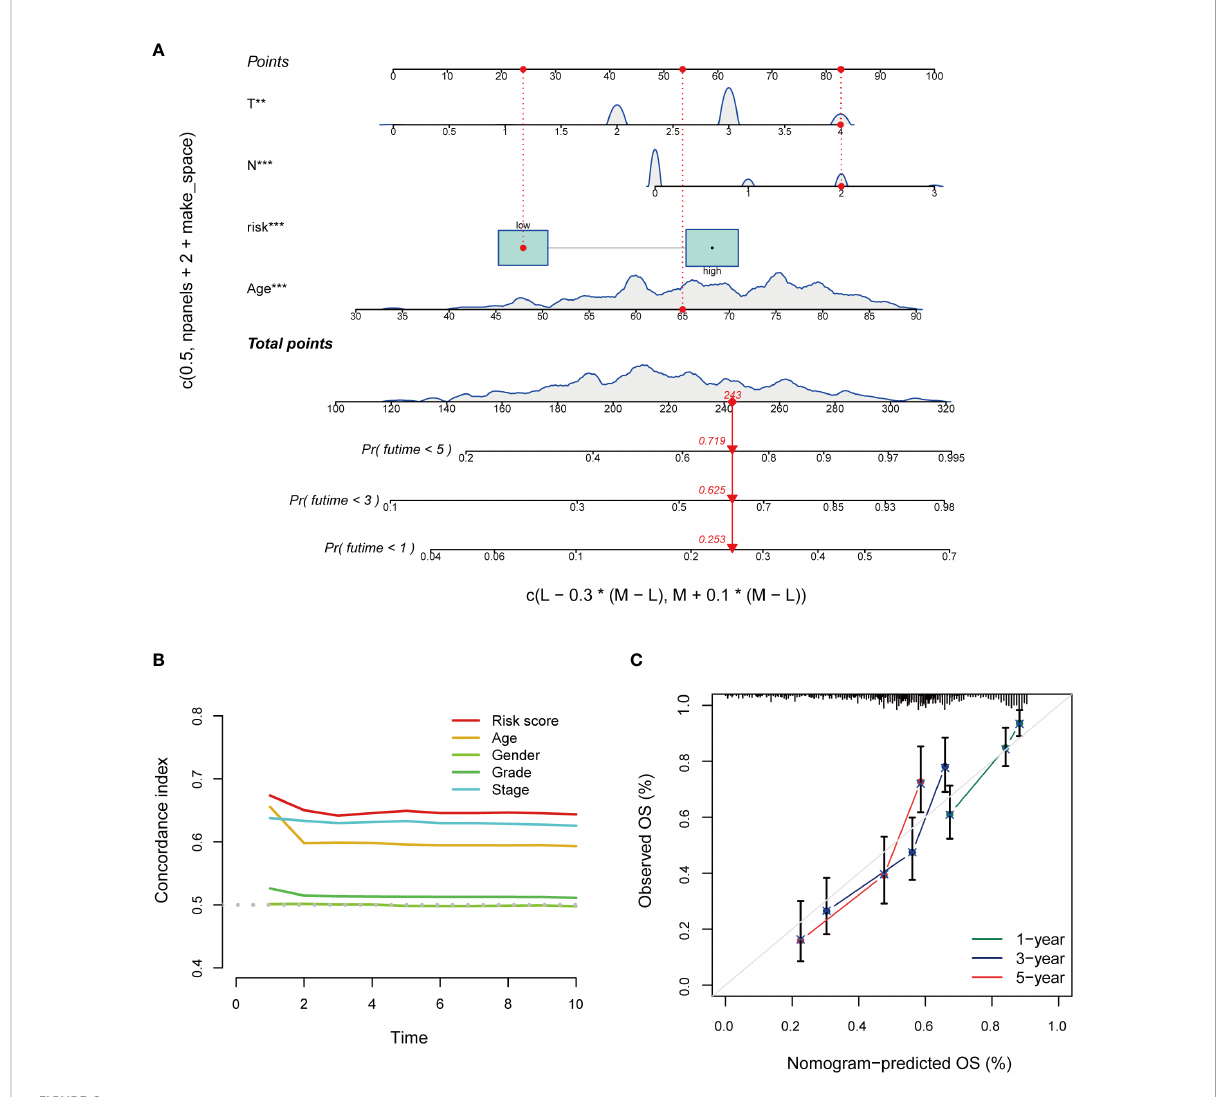
FIGURE 6 Construction and evaluation of the nomogram of the risk model. (A) Nomogram combines risk scores and clinical features to predict 1-, 3-, and 5-year overall survival. (B) Concordance index of risk score and clinical characteristics. (C) The calibration curves for 1-, 3-, and 5-year